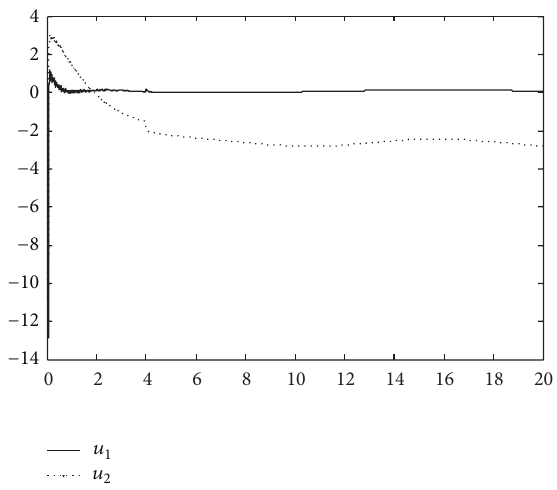
Figure 6: The curve of 𝑢(𝑡) with the proposed control scheme ((30a), (30b), (30c), (30d), and (30e)).